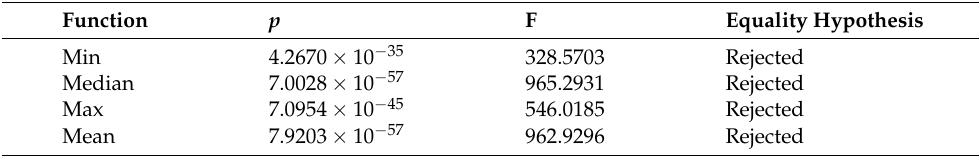
Table 3. Results of the ANOVA test for spine line data using different statistical functions. Rejection of hypothesis means that the means of data are significantly